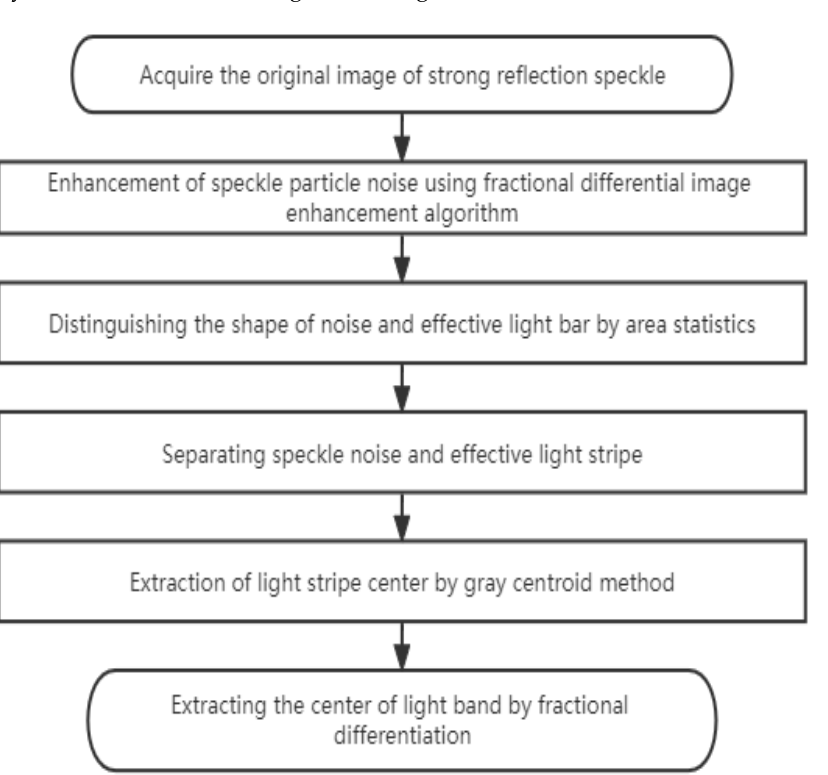
obtained by the gray center of gravity method: